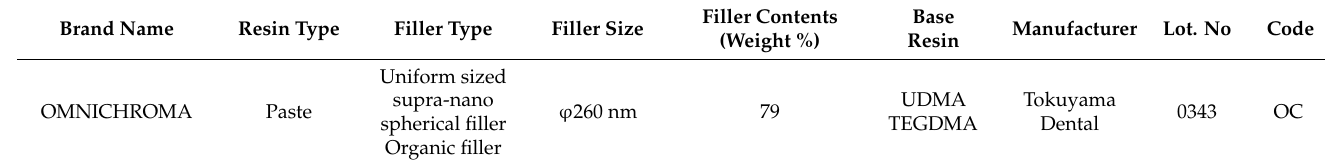
Table 2. Components of